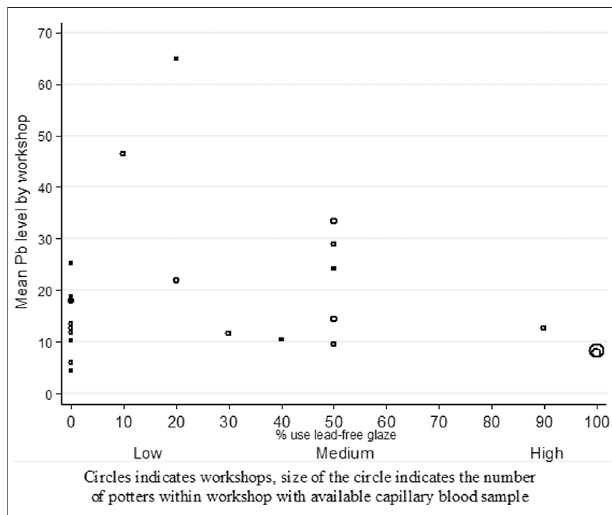
FIGURE1| Capillaryblood leadlevels (mcg/dl) clusterbyworkshop and presented by use of lead-free glaze.